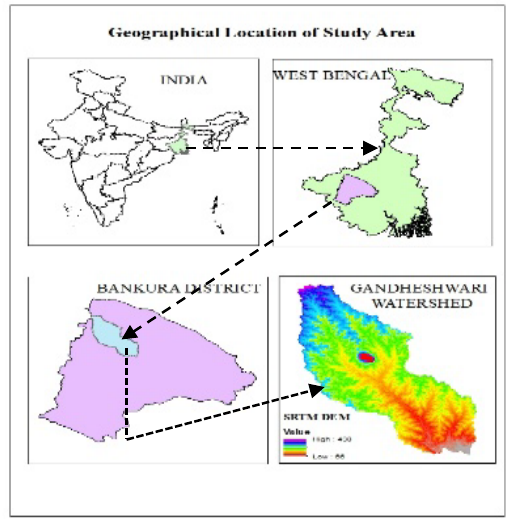
Figure 1. Location of the study area. The SRTM DEM of the Gandheshwari watershed was obtained from SRTM 1 Arc-Second DEM